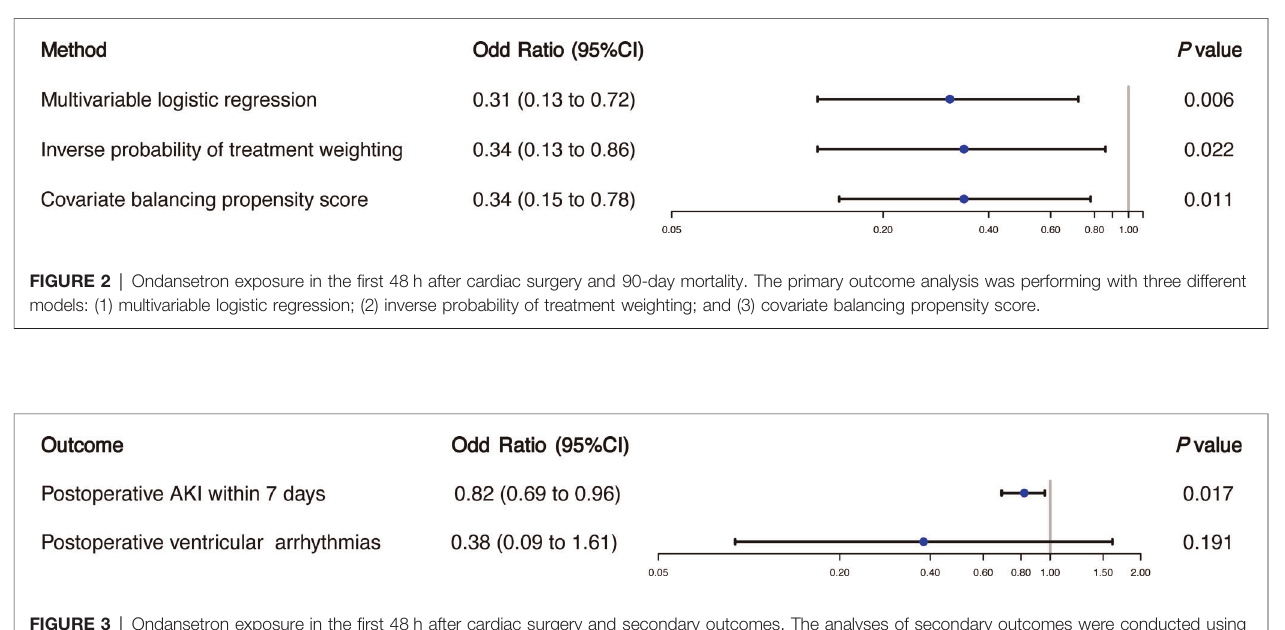
FIGURE 3 | Ondansetron exposure in the fi rst 48 h after cardiac surgery and secondary outcomes. The analyses of secondary outcomes were conducted using multivariable logistic regression